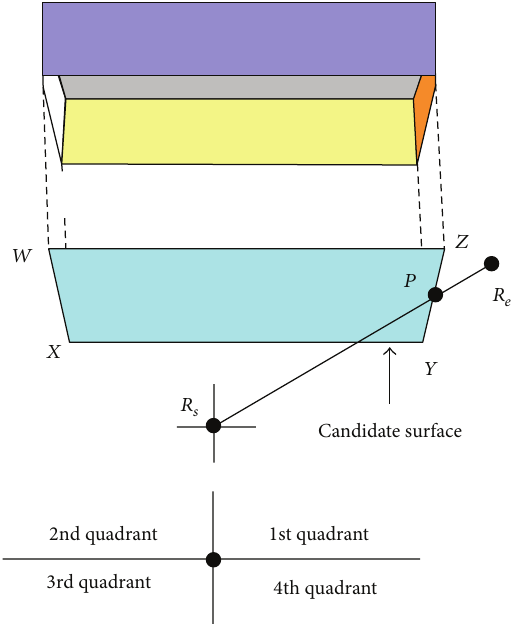
Figure 9: Illustration of the candidate surfaces.